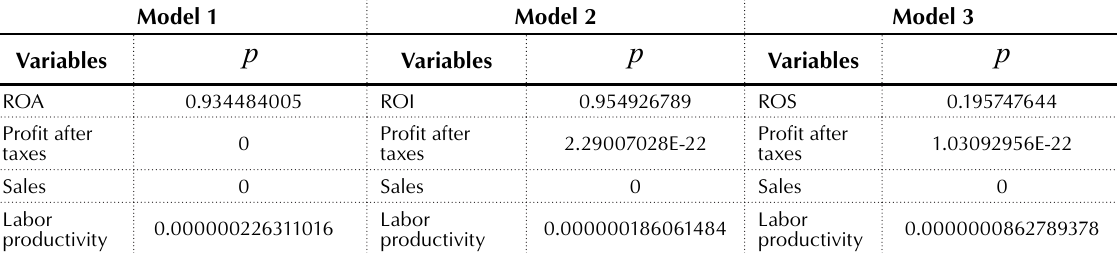
Table 6. Summary results of Fisher-Snedecor test criteria of the variables of each